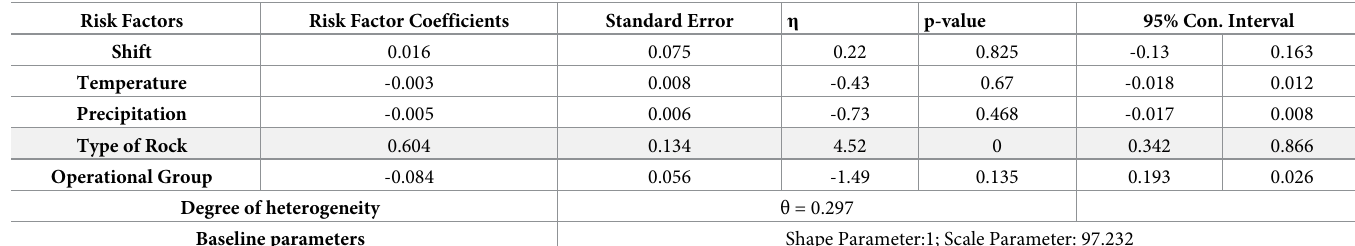
Table 5. The Exponential frailty estimated